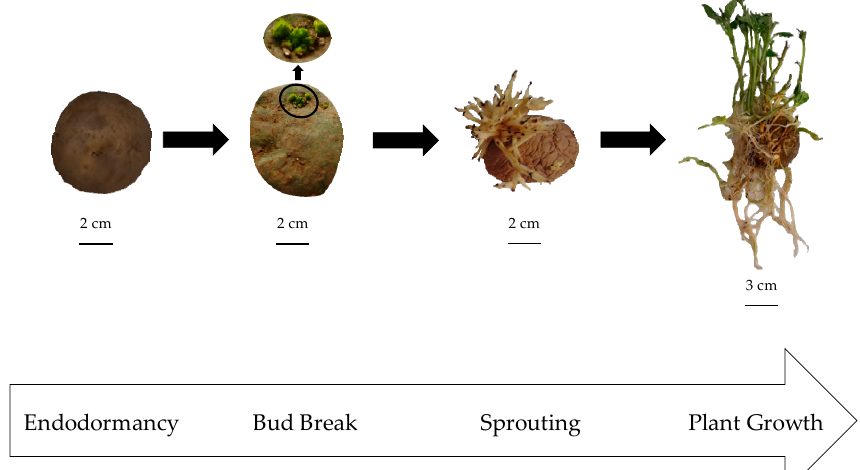
Figure 1. Four sequential stages of the potato tuber life cycle used to assess changing status of patatin phosphorylation in Kennebec cultivar: endodormancy, bud break (2 mm apical bud length), sprouting (5 cm bud length) and plant growth (12 cm stem